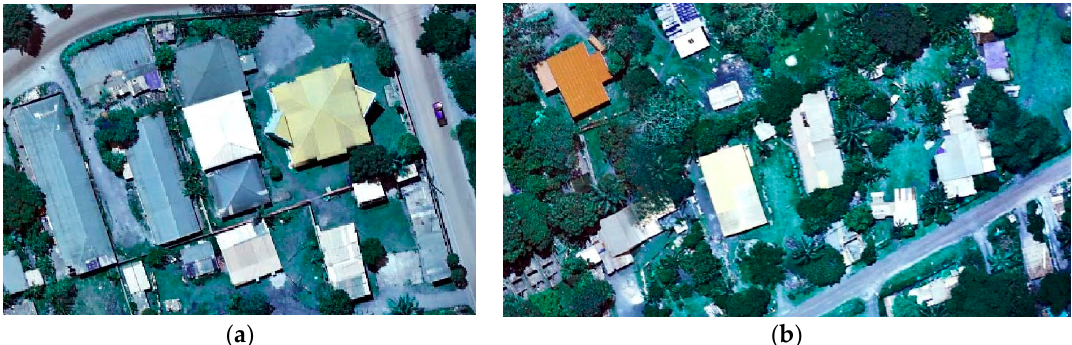
Figure 2. The illustration of parcels in ( a ) region 1—dense urban, and ( b ) region 2—suburban.